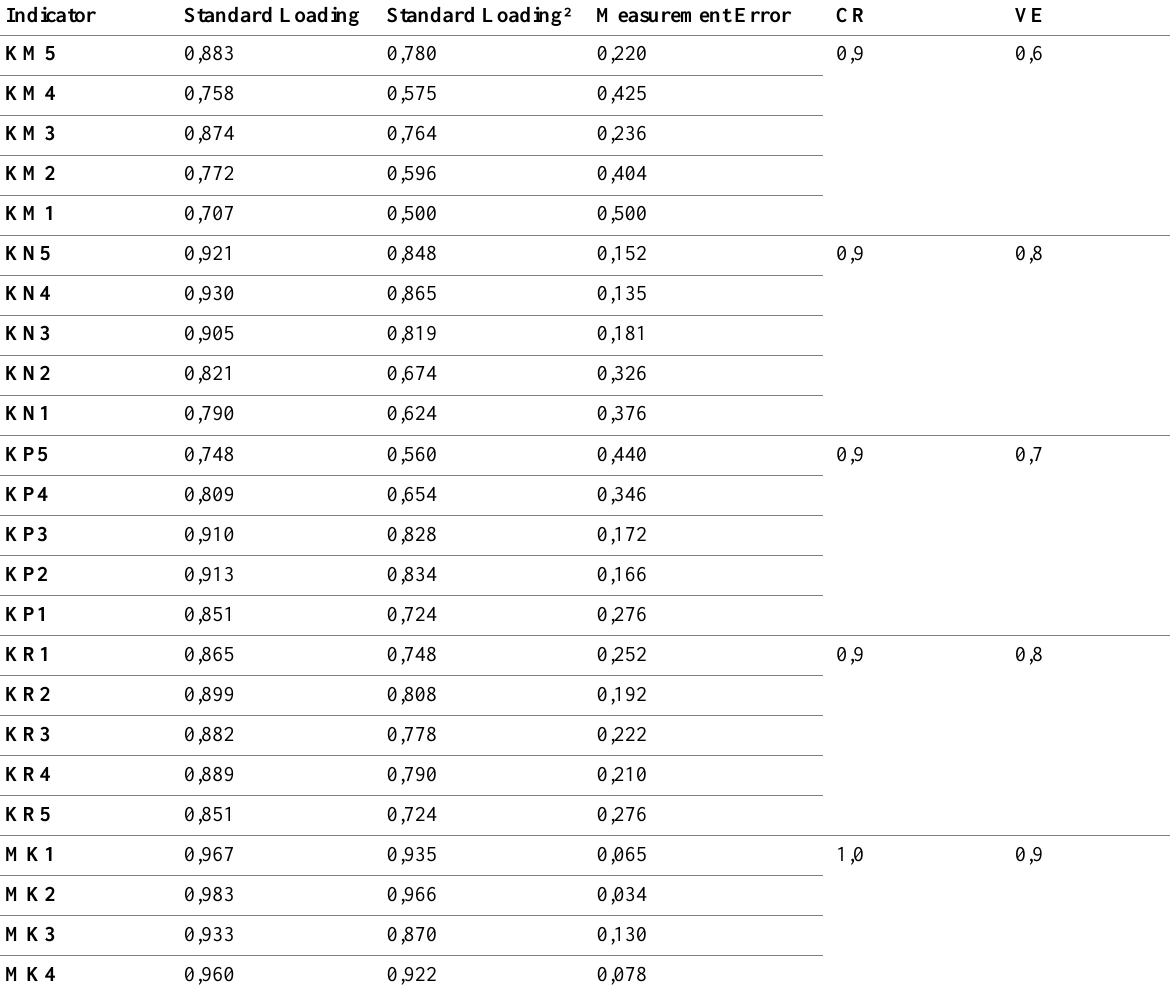
Table 1: Validity and Reliability